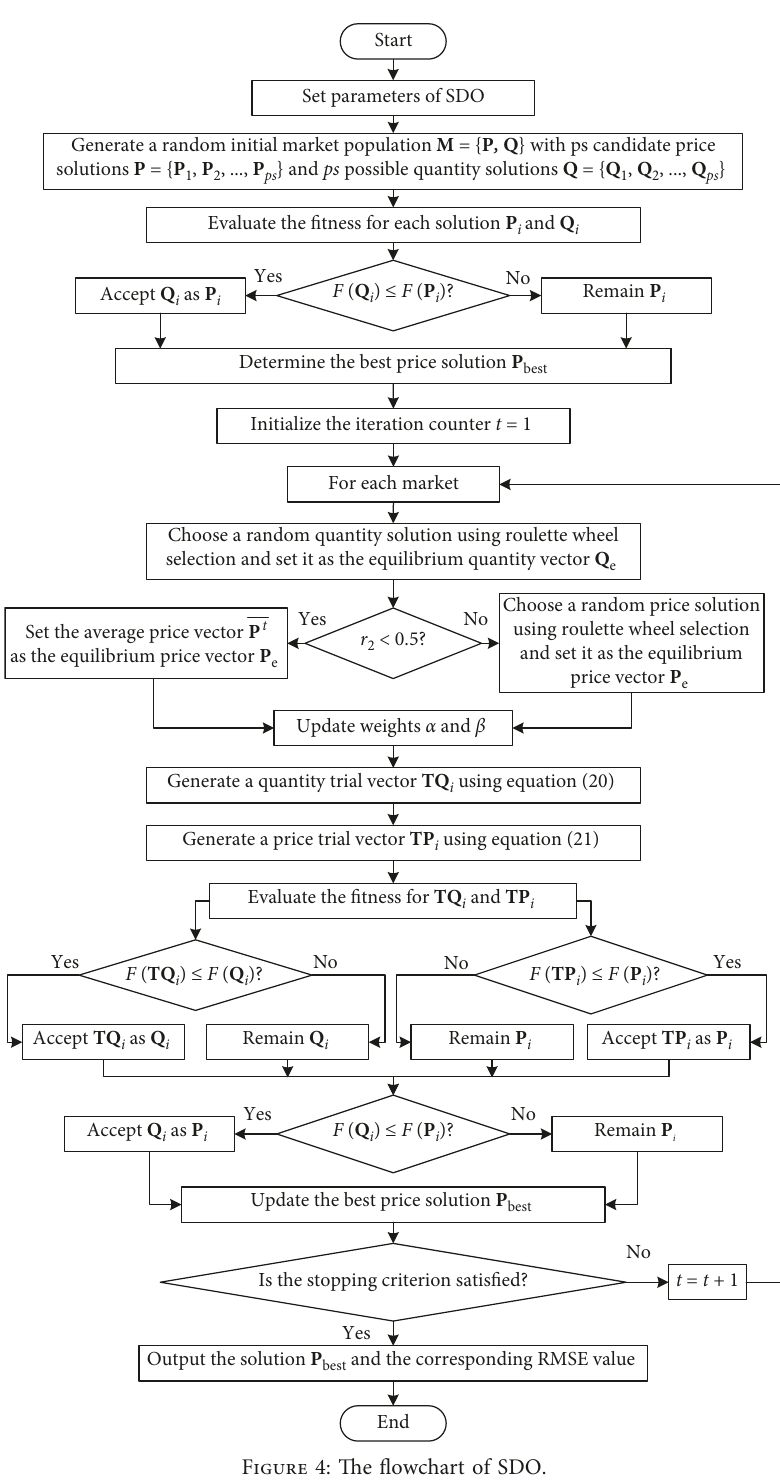
Figure 4: The flowchart of